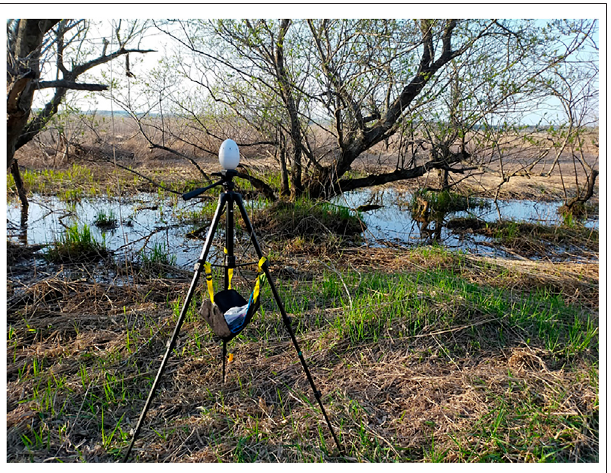
FIGURE 4 | Photograph of the 8-channel microphone